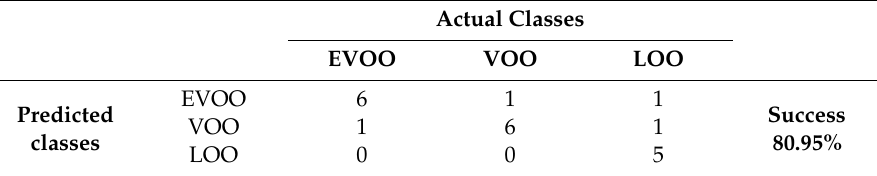
Table 6. Validation matrix by k-NN using data fusion of HS-GC-MS and HS-GC-IMS.